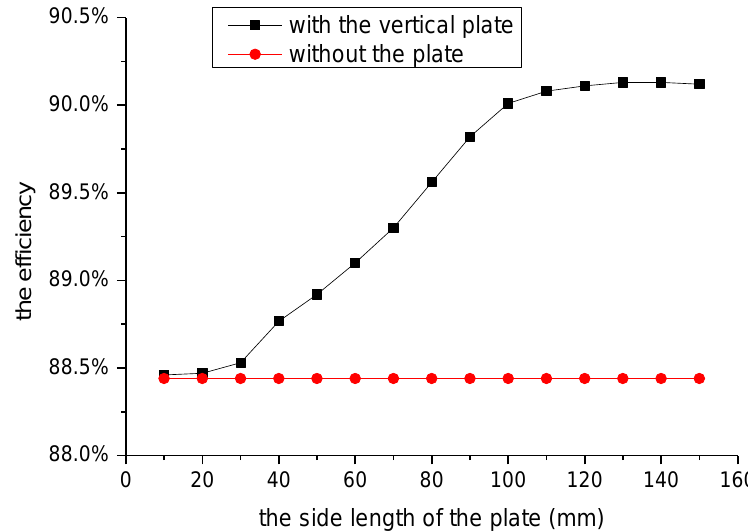
Figure 9. The variation of the system efficiency with the size of the vertical plate.